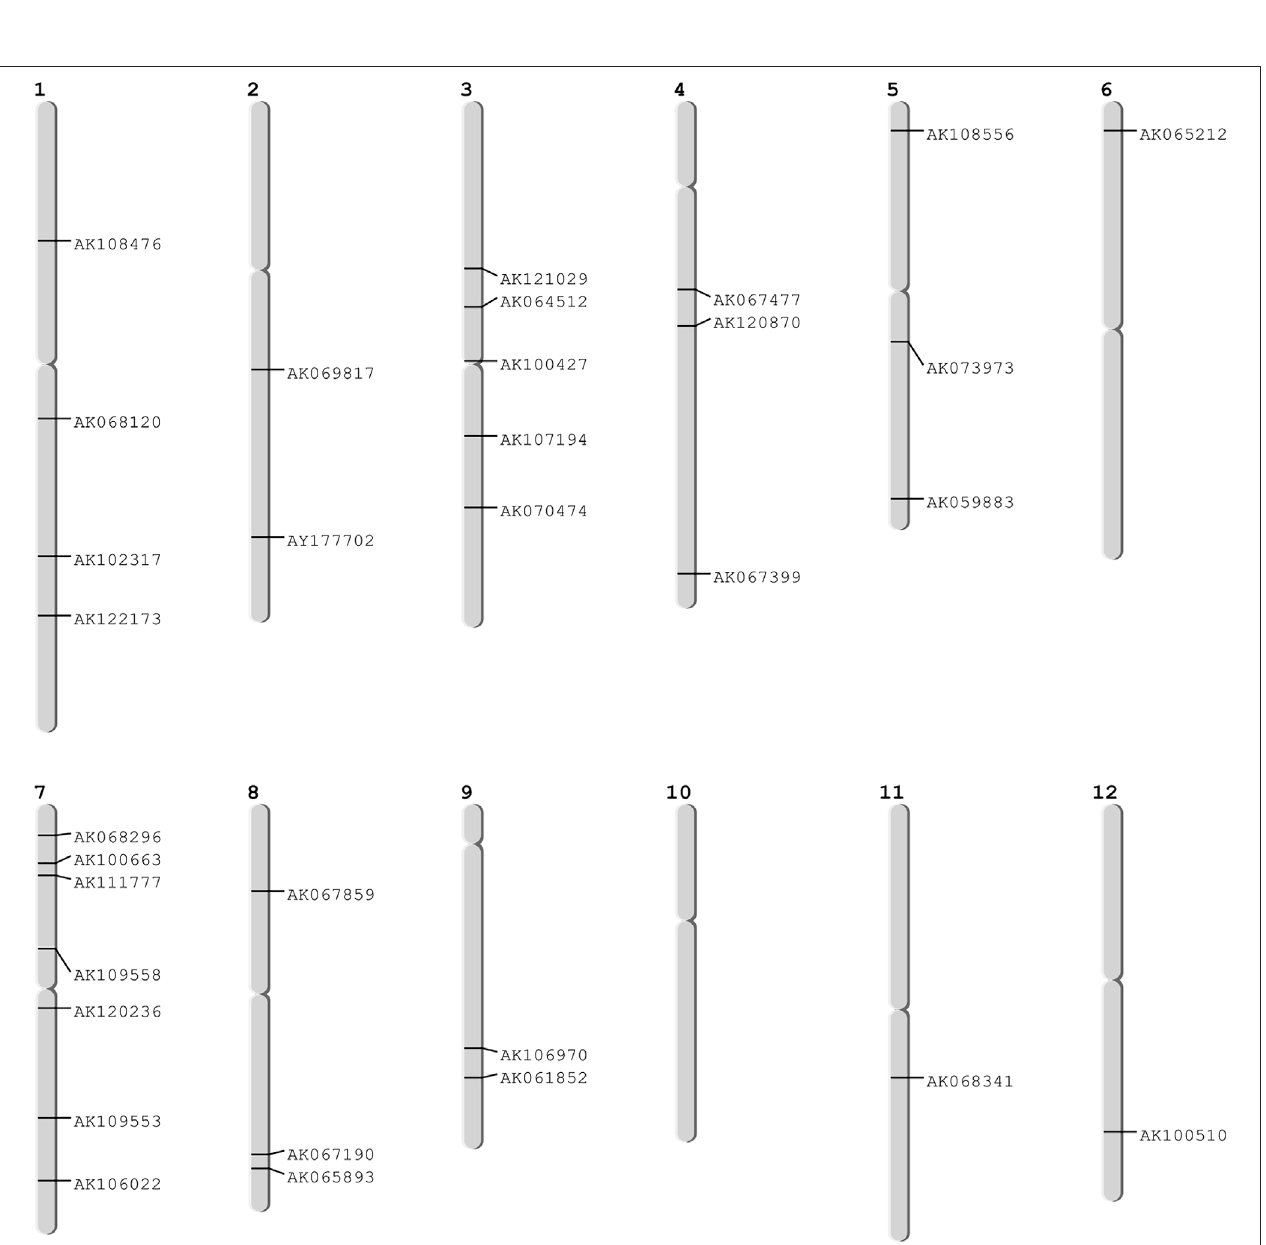
FIGURE 7 | Mapped hub genes on different